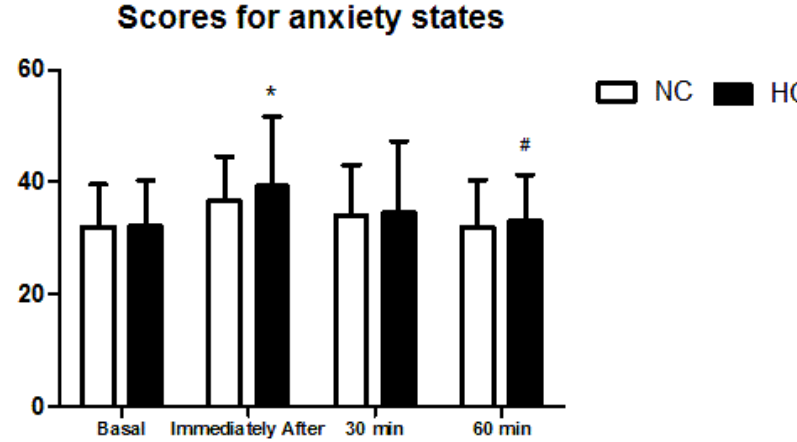
Figure 2. Two-way ANOVA with repeated measures followed by Duncan’s post hoc test was performed. *compared with the same baseline con- dition; #compared with the same condition immediately after exercise. Results were considered significant for p ≤ .05. The data are expressed as the mean ± standard deviation.